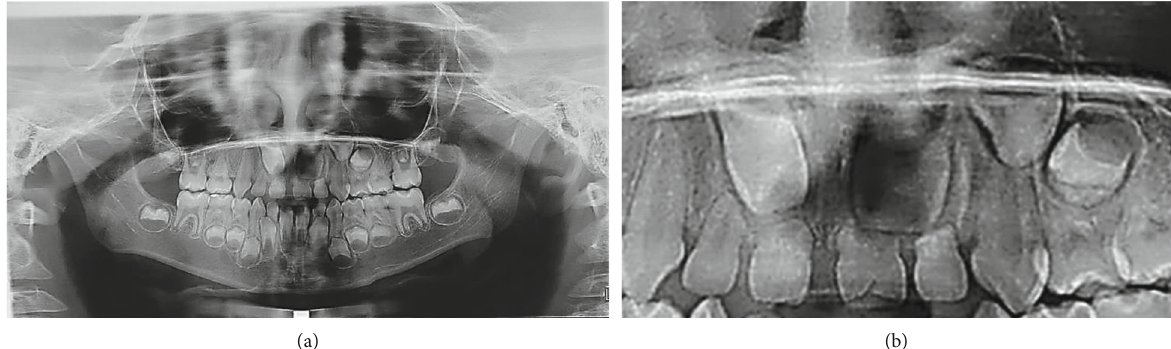
Figure 4: Panoramic X-ray shows teeth 17-11-21-23-24 and 27 in intraosseous formation, in Nolla stage between 3 and 5. The formation of the other maxillary permanent teeth is not appreciated, indicating their agenesis (a and b). Panel (b) shows a close-up view of the anterosuperior area. The formation of teeth 12, 22, and 13 is not